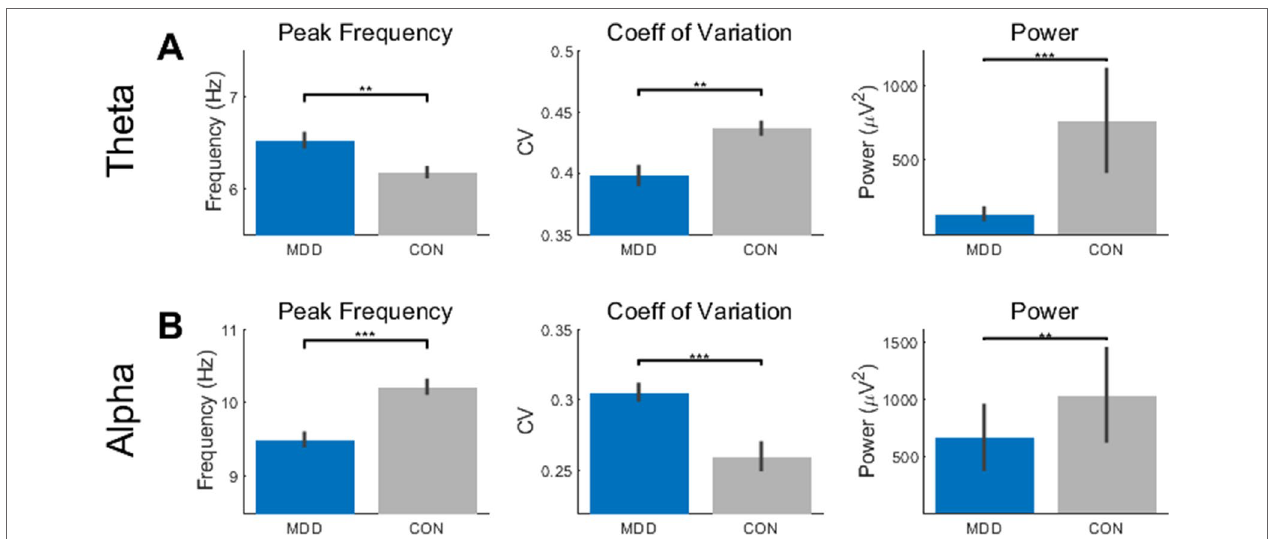
FIGURE 1 | Resting state activity showed differences in theta and alpha between the MDD group and healthy controls. (A) The peak frequency (PF), coefficient of variation (CV), and power measures showed higher PF, lower CV, and lower power in the MDD participants than the controls. (B) In the alpha band, the MDD group had lower PF, higher CV, and lower power. All p -values are FDR corrected for multiple comparisons. **: < 0.01, ***: